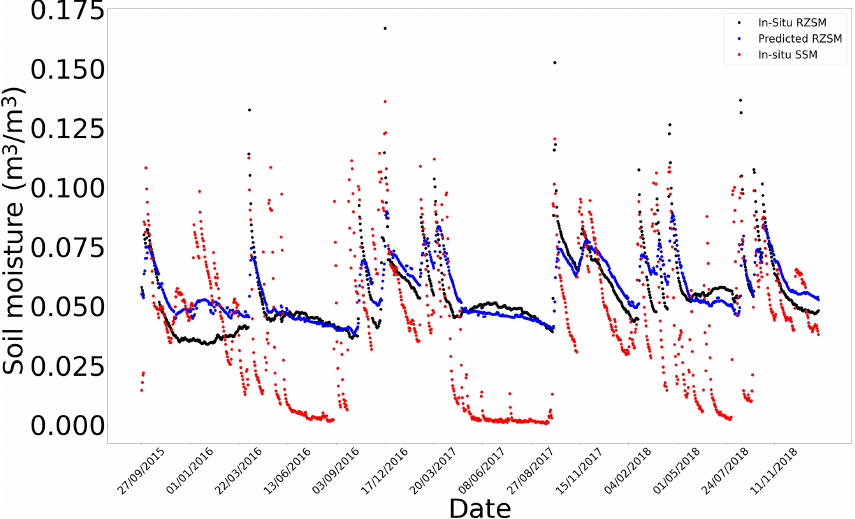
Figure G6. In situ SSM, in situ RZSM, and predicted RZSM series at station Bouhajla_164 (Tunisia) with model ANN_SSM_NDVI_EVAP-